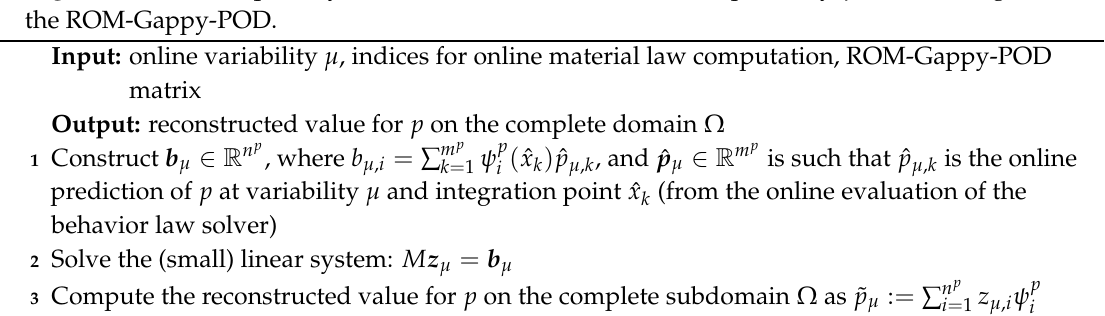
Algorithm 4: Dual quantity reconstruction of the cumulated plasticity p : online stage of the